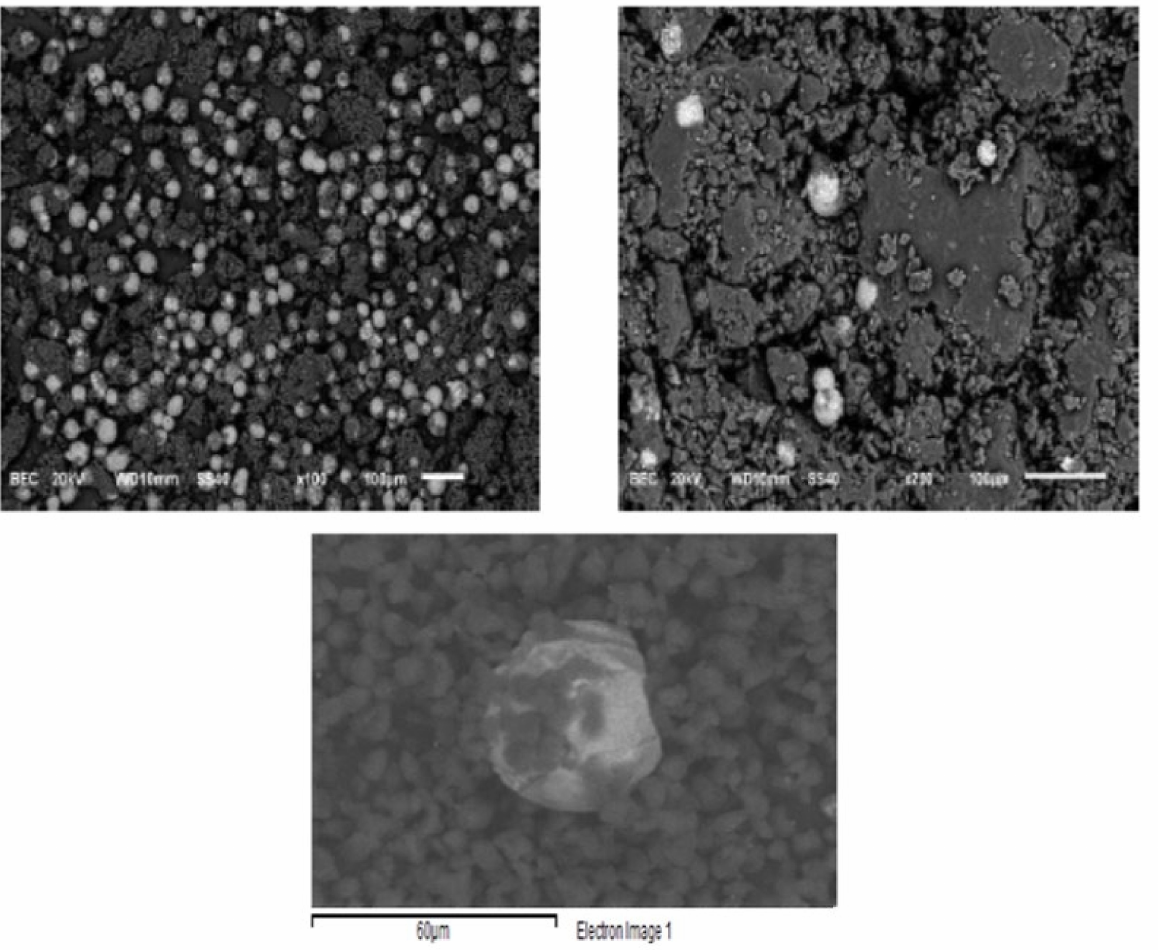
Figure 8. Scanning electron microscopy (SEM) images of the magnetic product ( upper left ), the nonmagnetic product ( upper right ) and a close view for size comparison between iron oxide particles and polystyrene particles ( bottom